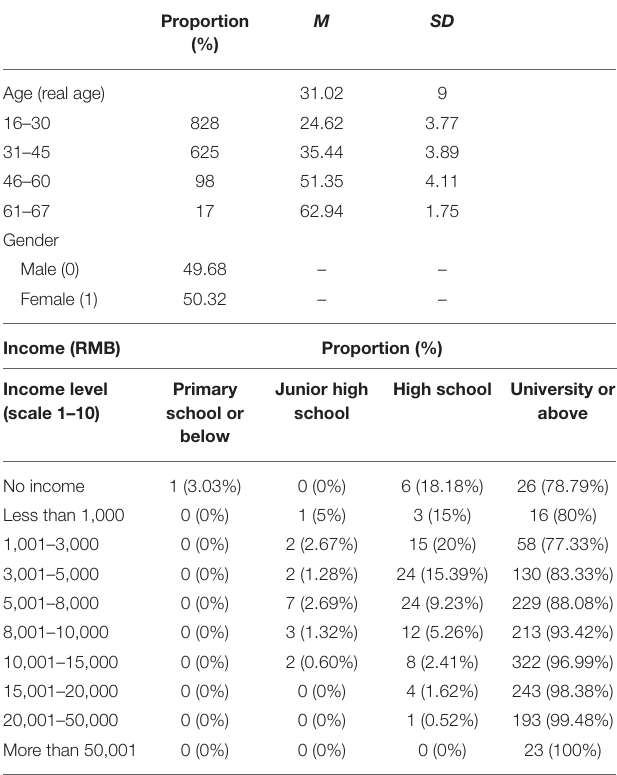
TABLE 1 | Socioeconomic characteristics of